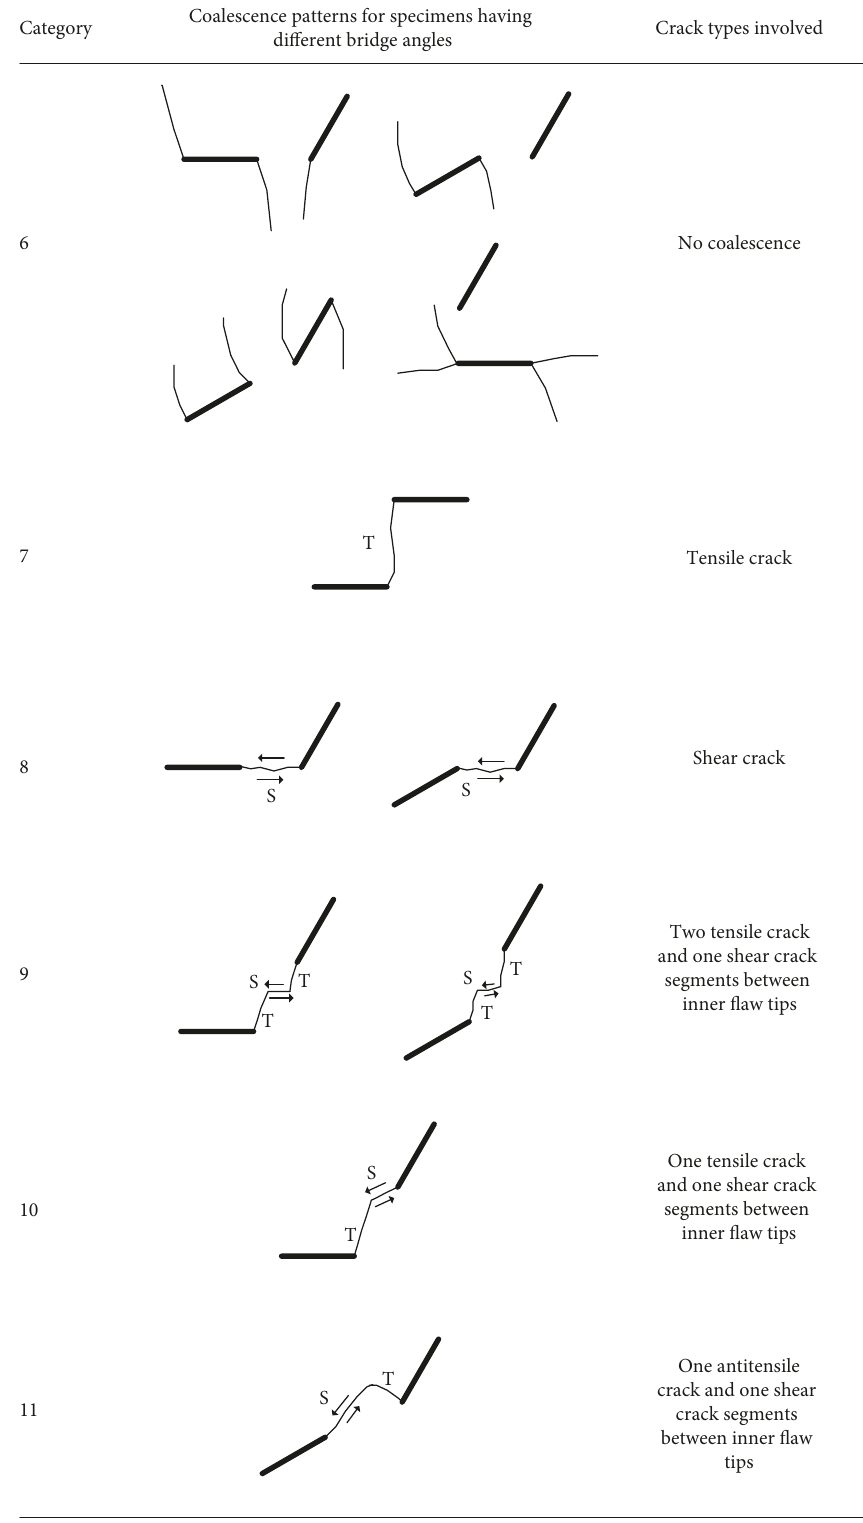
Figure 10: Types of coalescence in triaxial compression for specimens with geometries of 20-0-60- β and 20-30-60- β with different bridge